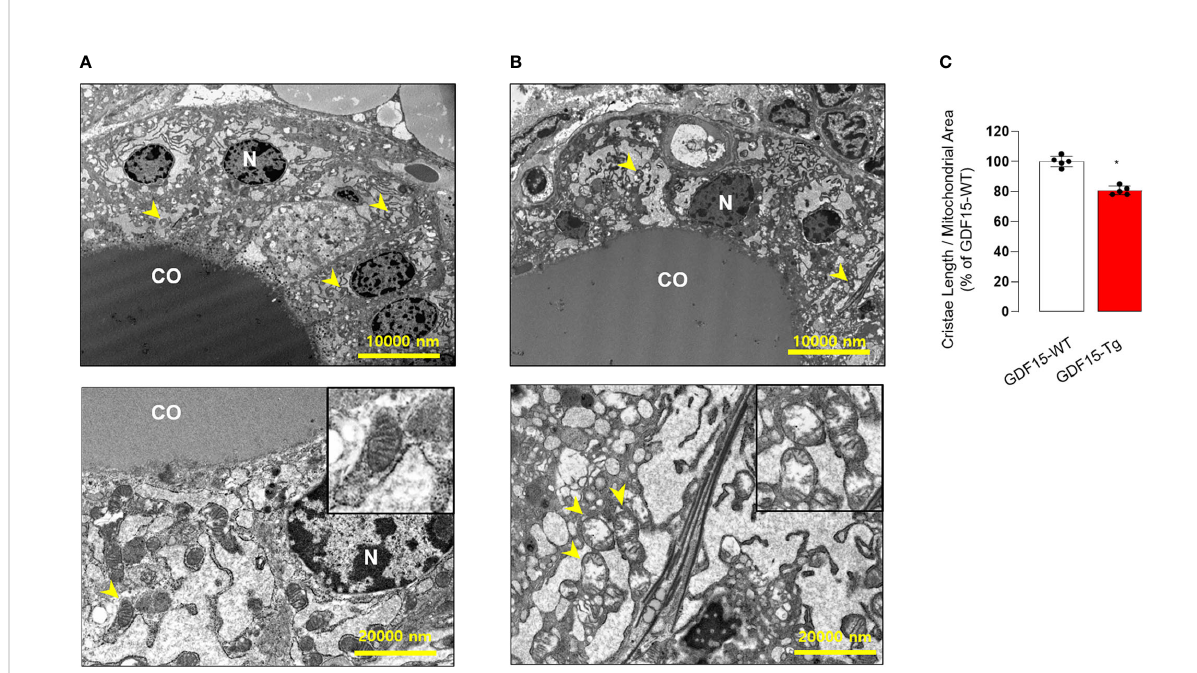
FIGURE 4 Comparison of transmission electron microscopic features between the thyroid glands from wild type (WT) and GDF15 transgenic (Tg) mice. (A, B) Representative images of transmission electron microscopy from WT (A) and GDF15 Tg (B) mice. High magni fi cation images of representative mitochondria (yellow arrowheads) are shown in the insert of the corresponding panel. (C) Comparison of relative cristae length between the two groups (n = 5). CO: follicular lumen that contains the colloid; N: nucleus; Yellow arrowhead: mitochondria. * Statistically signi fi cant differences in nonparametric Mann-Whitney U-test (p-value